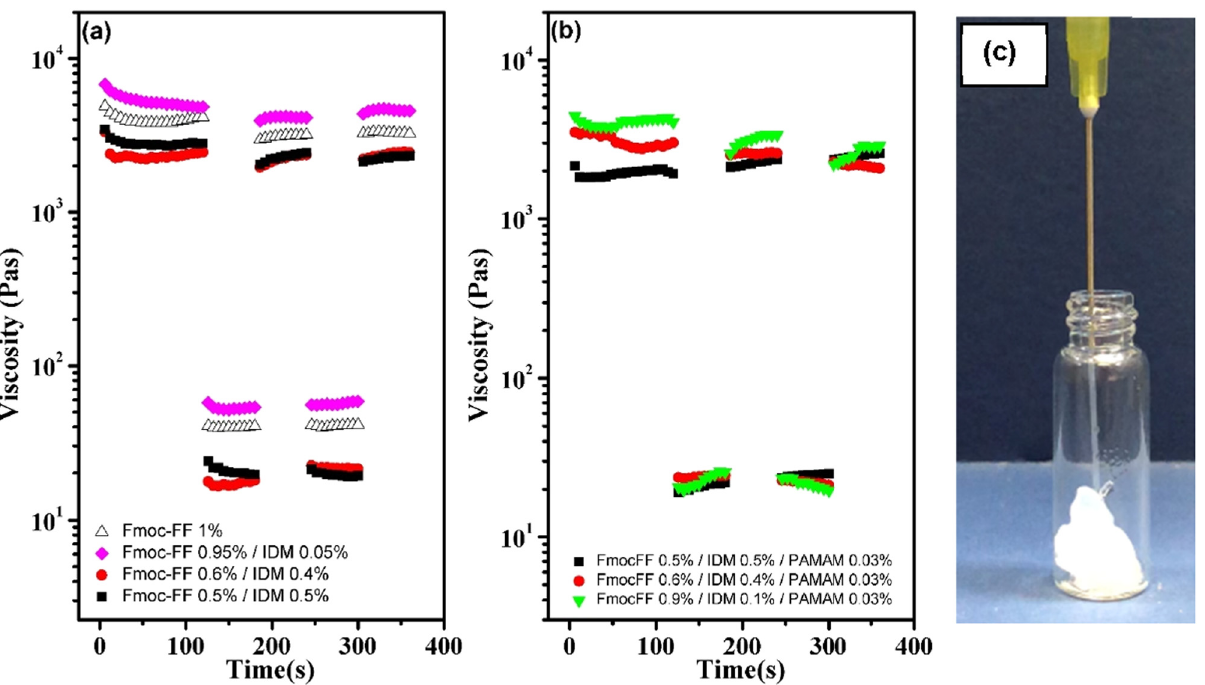
Figure 12: Step shear rate test for ( a ) Fmoc - FF – IDM hydrogels with varying IDM content and ( b ) Fmoc - FF – IDM – PAMAM hydrogels with varying IDM content and fi xed PAMAM concentration of 0.03%. ( c ) Photograph of typical hydrogel injection through the syringe